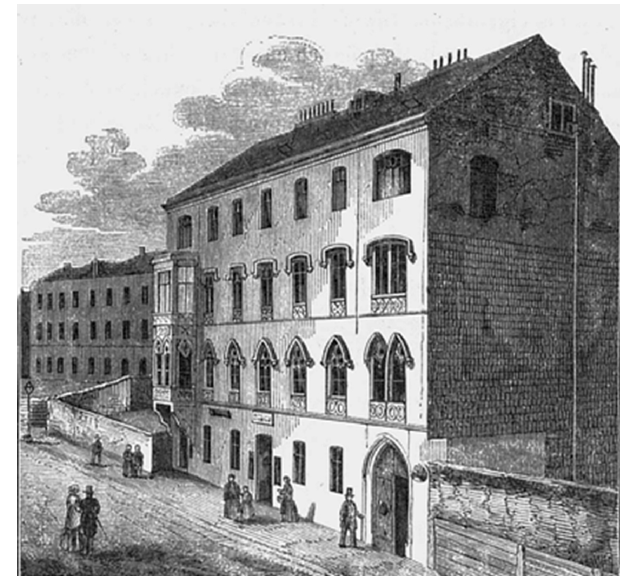
Figure 1. First quarters of the institution 1852 (ZAMG, 1856).